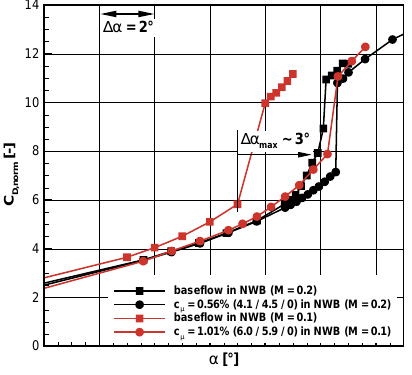
Figure 6. Comparison of results obtained in the NWB wind tunnel at M = 0.1 and M =